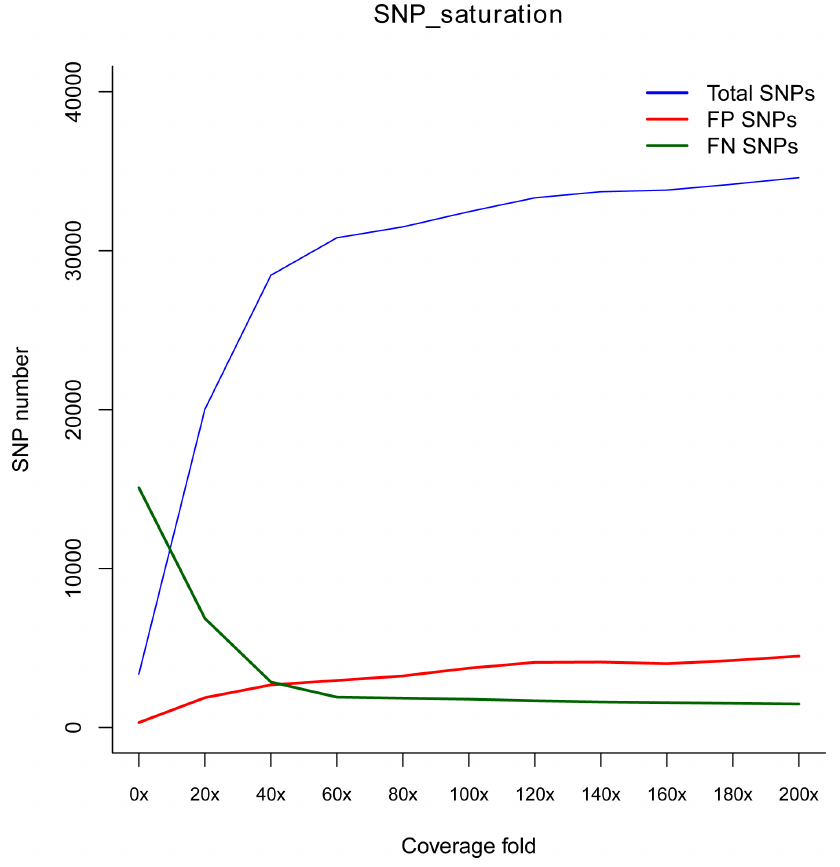
Figure 7. The analysis of total SNP, FN and FP under coverage folds.